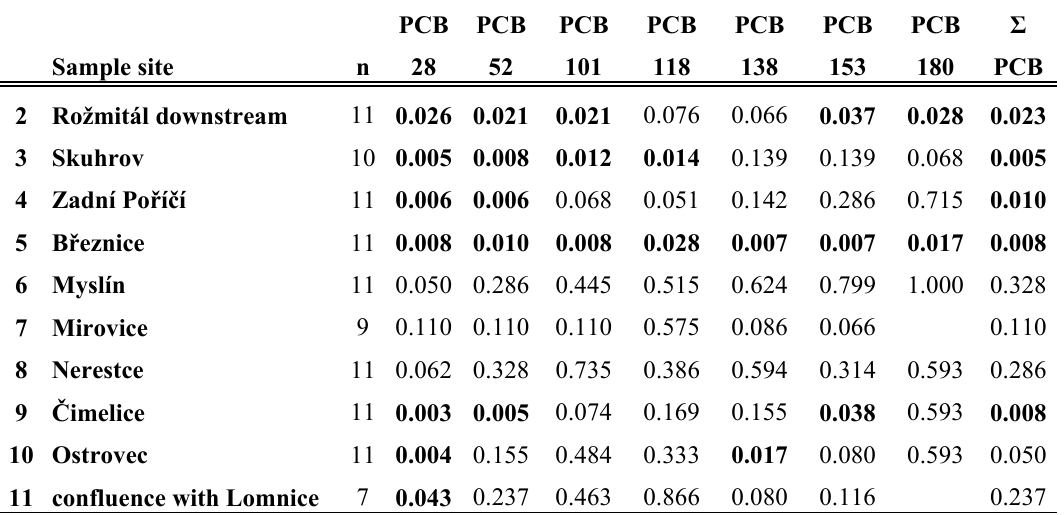
Table 2. Comparison of PCB content at 10 monitored sites with control site Rožmitál. Wilcoxon matched pairs test; p < 0.05 indicate significant difference from the control site (n = the number of years that leeches were